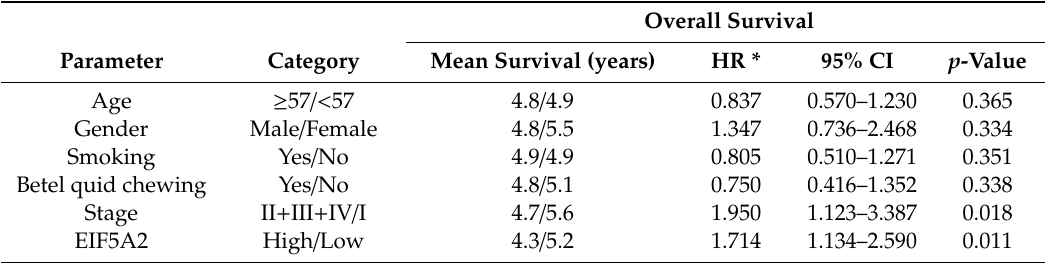
Table 4. Multivariate analysis of the influence of various parameters on the overall survival of oral cancer patients.